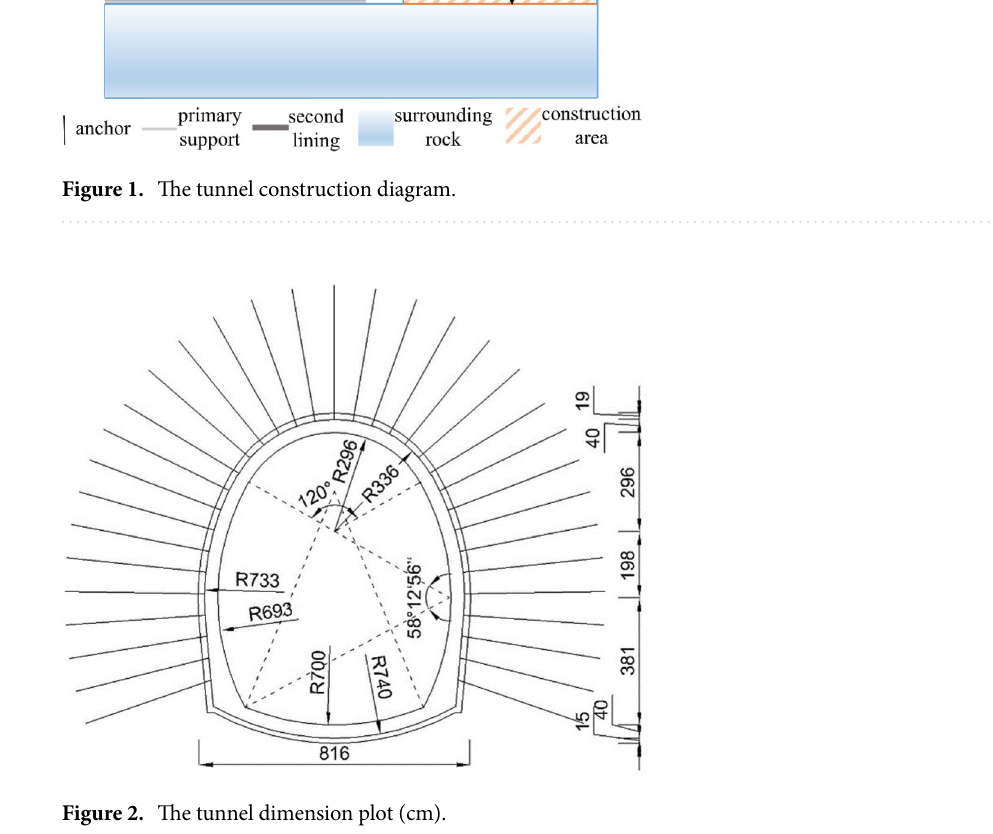
Figure 2. The tunnel dimension plot